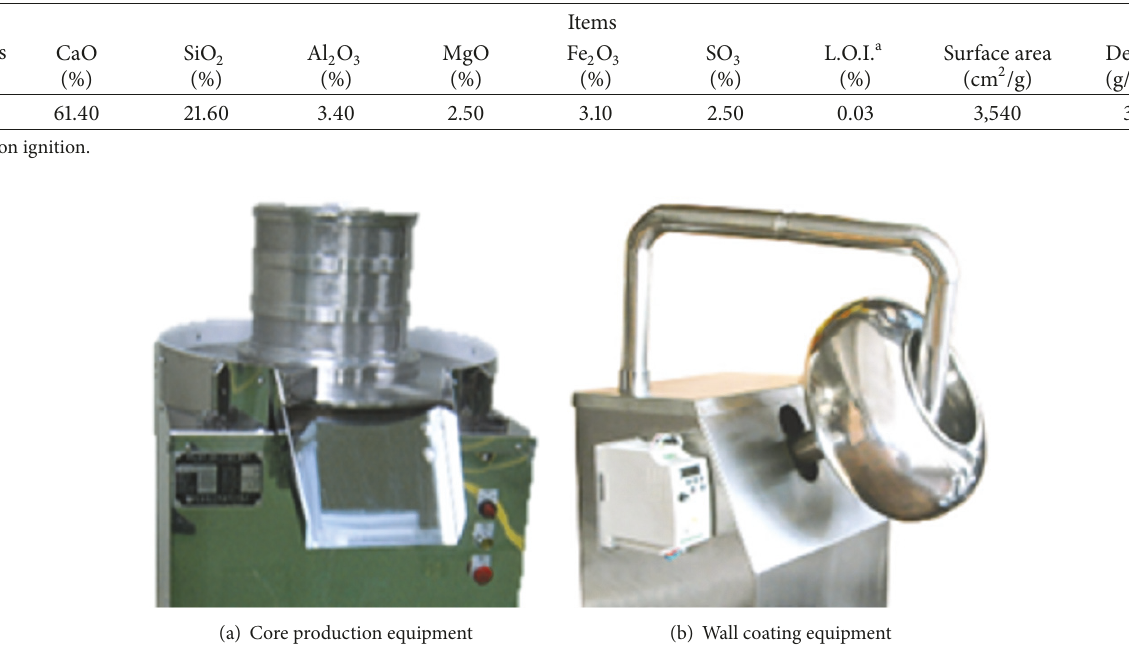
Figure 1: Capsule manufacturing